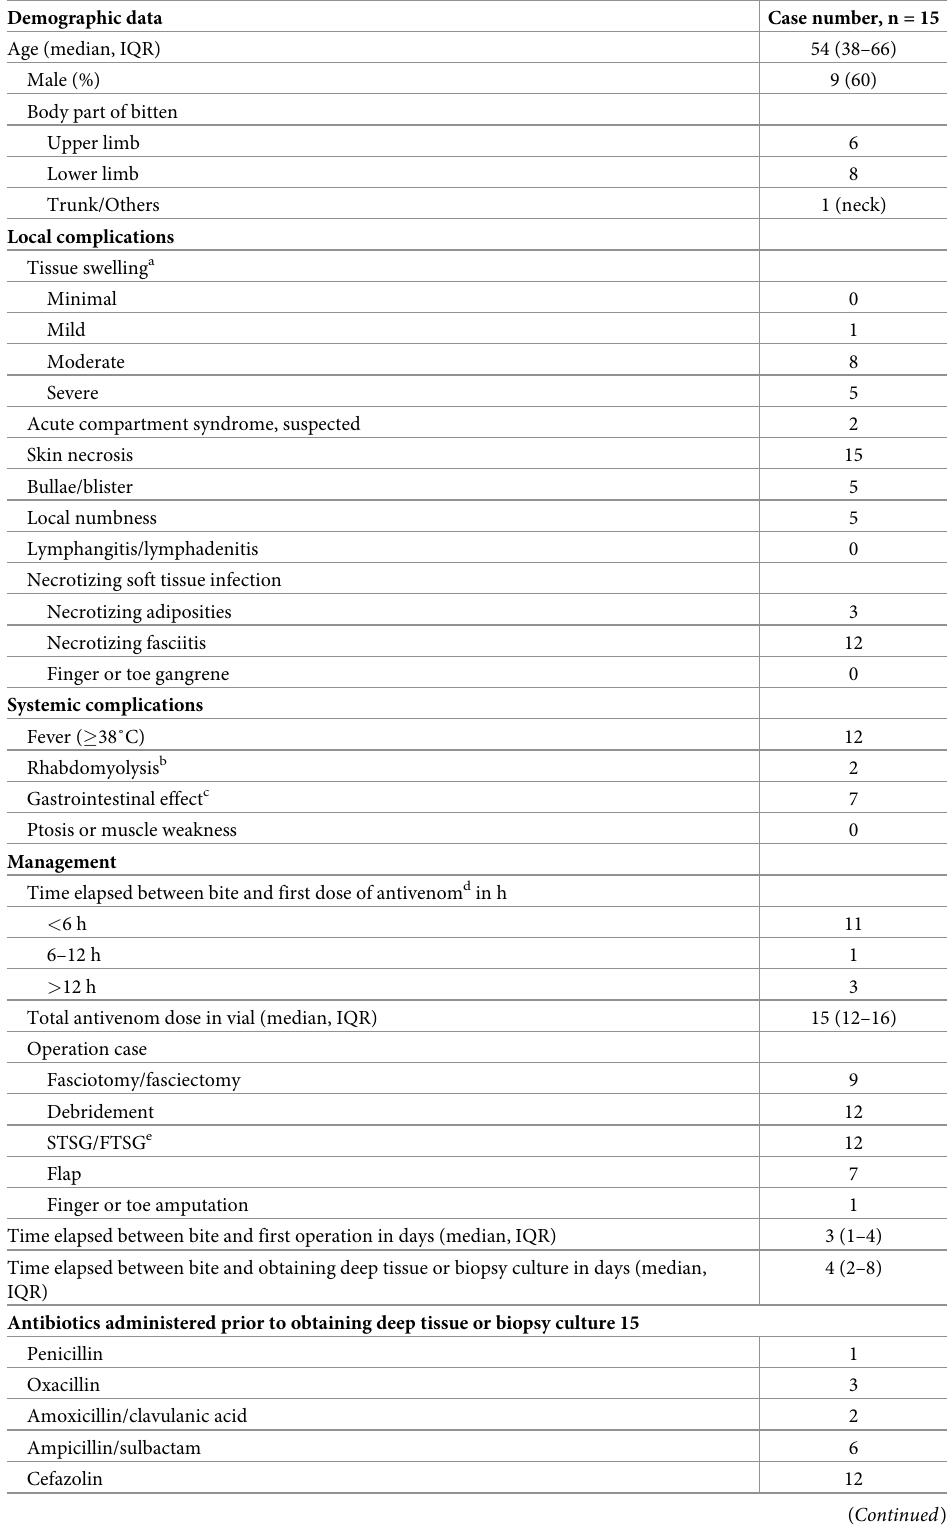
Table 1. Demographic data and management of patients with positive deep tissue or biopsy